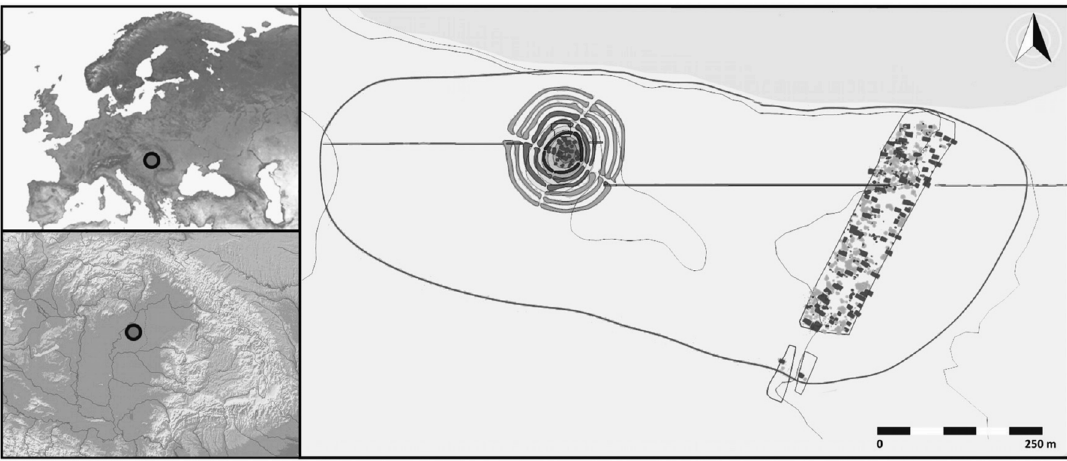
Figure 1: Situation of Polgár-Csőszhalom and the two settlement